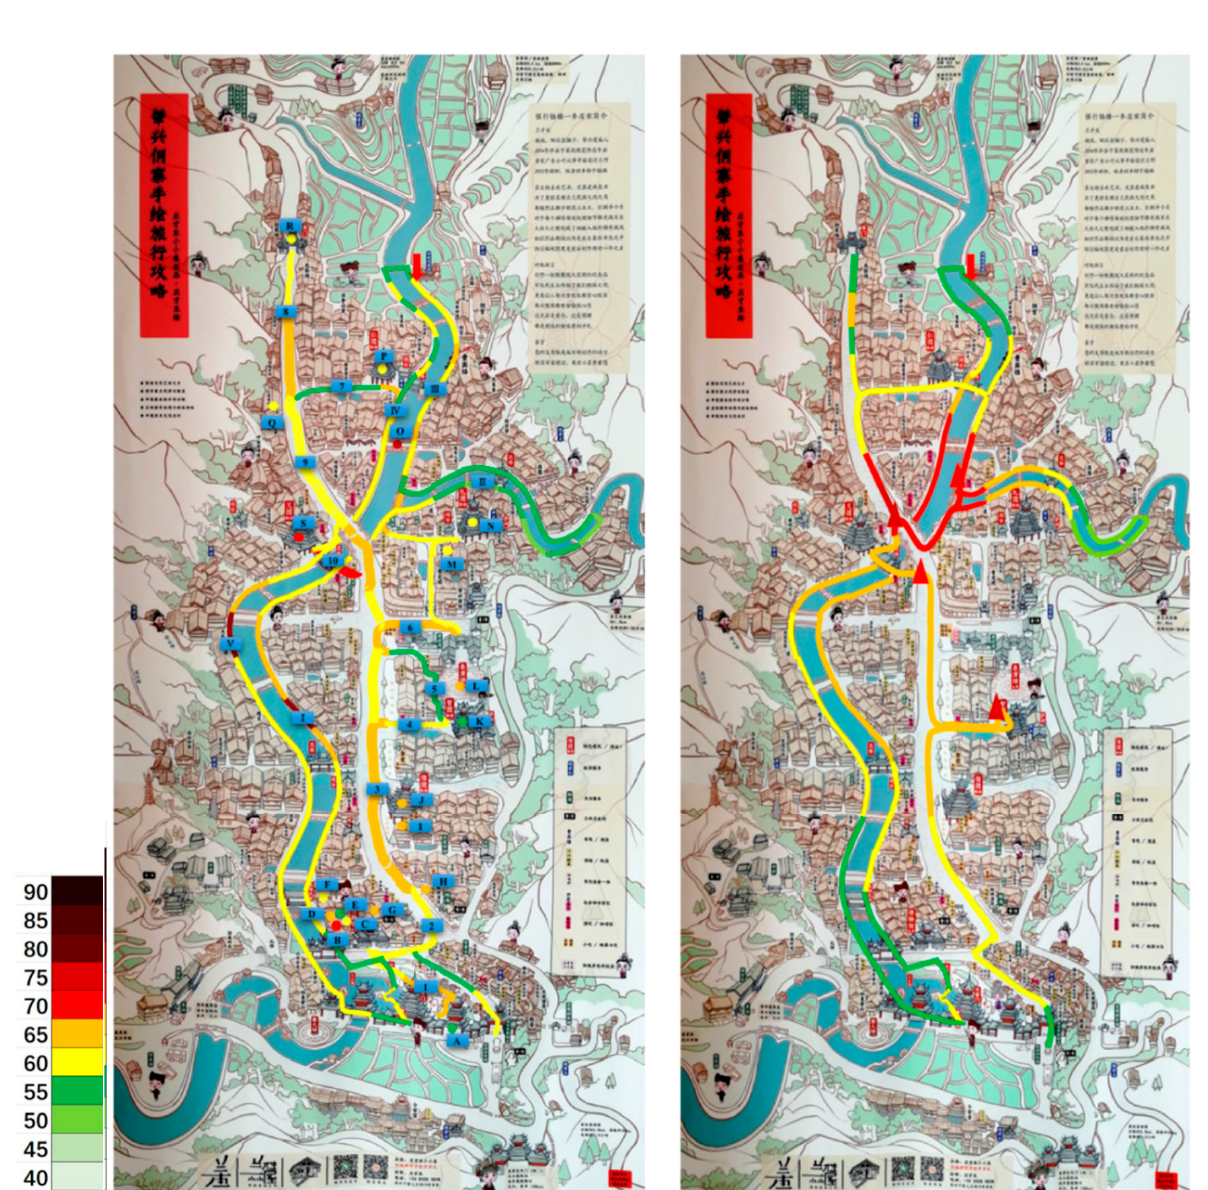
Figure 2. Sound level mapping (in LA eq ) of Zhaoxing Village during the day (left) and night (right, the estimated value for riverside soundwalk at night).